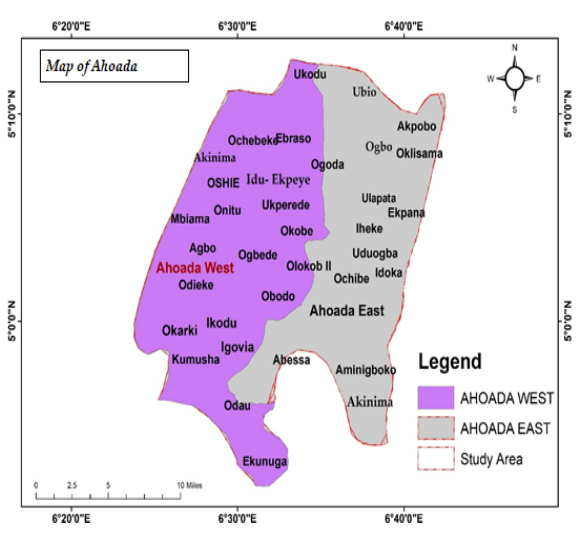
Figure 1 . Map of Ahoada communities